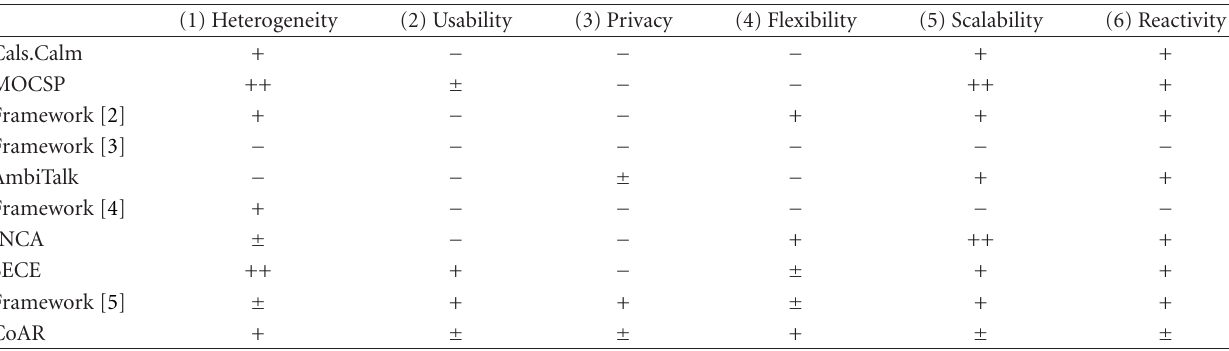
Table 1: Comparison between CAC